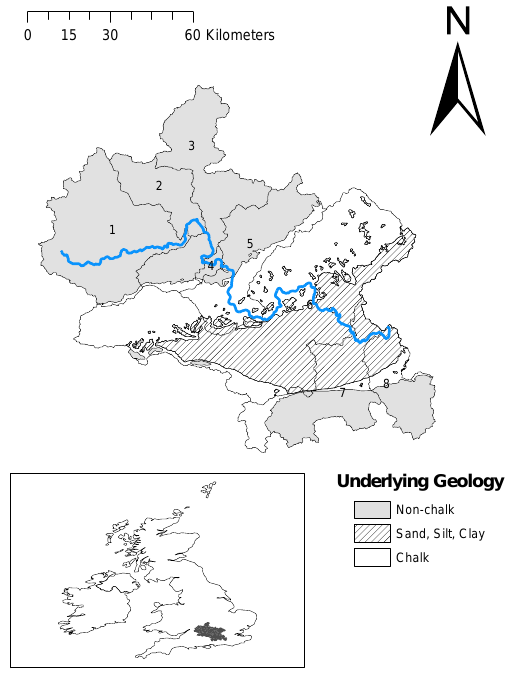
Fig. 4. Map of the river Thames watershed showing the main branch of the Thames, underlying geology and boundaries for the 8 sub- catchments used in the present study. The flow gauging stations are located where the main branch of the river crosses the subcatchment